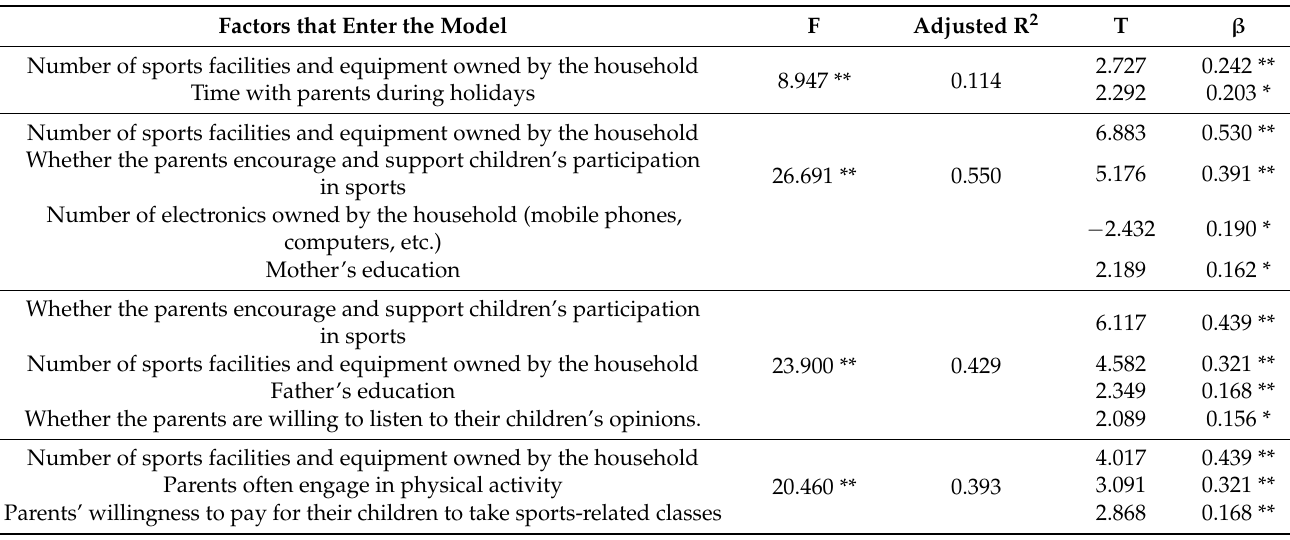
Table 4. Multiple regression models of the influence of family environment on the scientific fitness literacy of